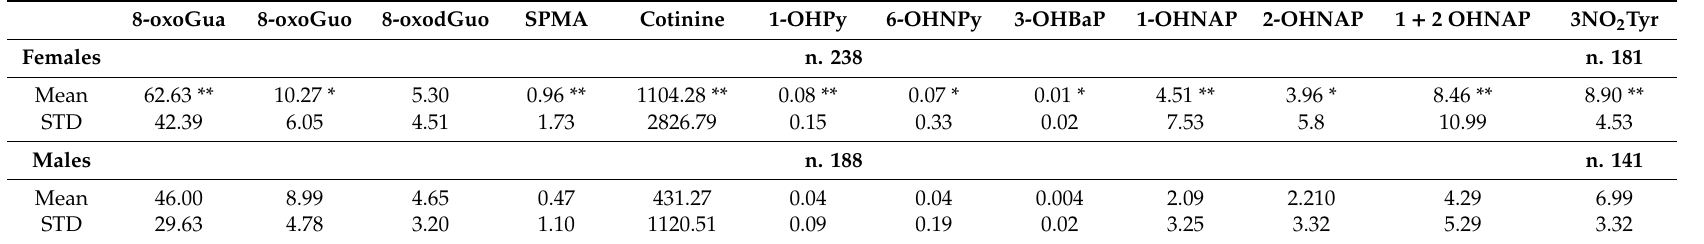
Table 4. Mean urinary concentrations of 11 biomarkers in males and females expressed in µ g / g Creatinine.